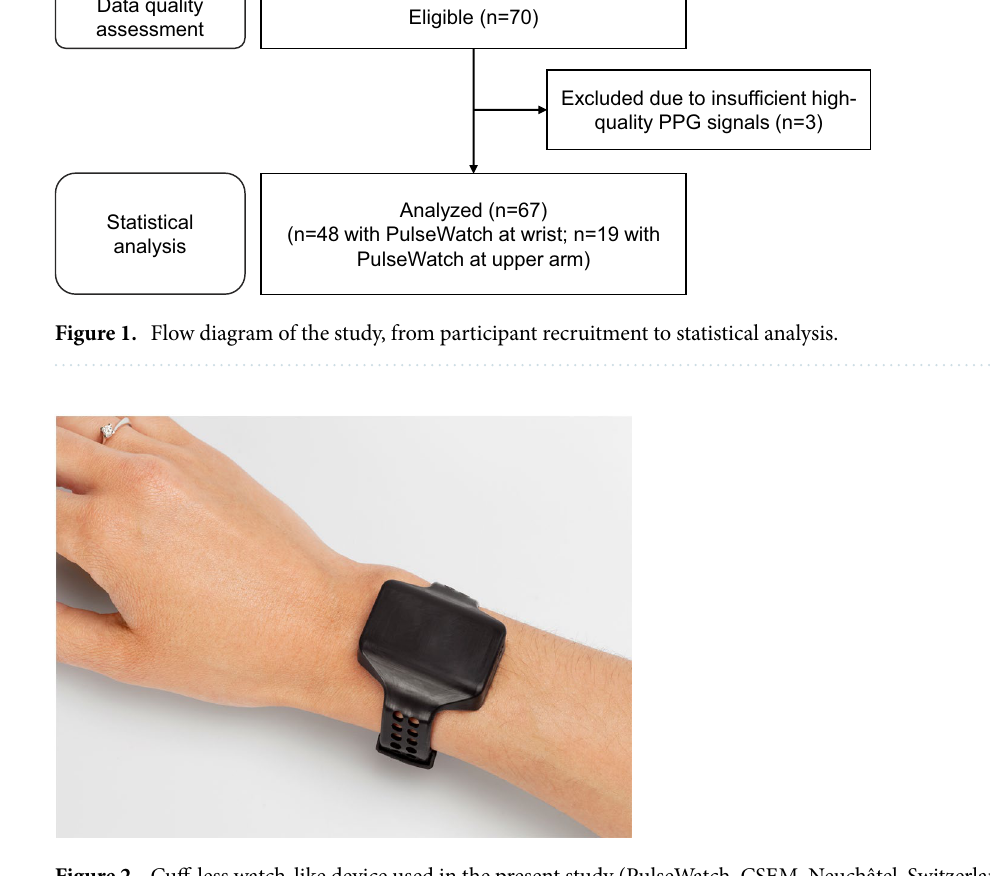
Figure 2. Cuff-less watch-like device used in the present study (PulseWatch, CSEM, Neuchâtel, Switzerland), which contains a photoplethysmographic (optical) sensor and an accelerometer, and can be attached at the wrist or the upper